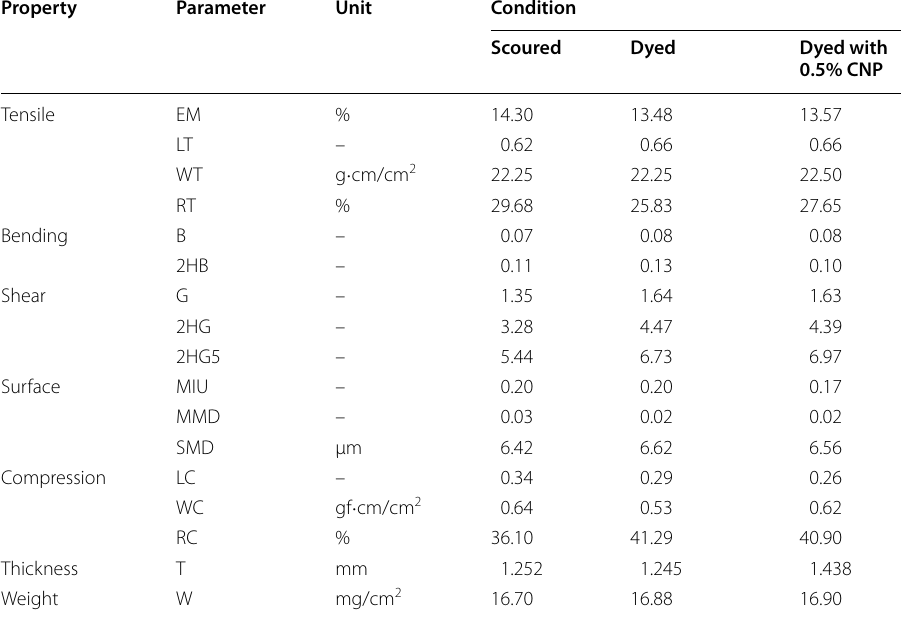
Table 4 Mechanical properties of cotton dyed with Euphorbia with and without cellulose nanoparticles (CNP)